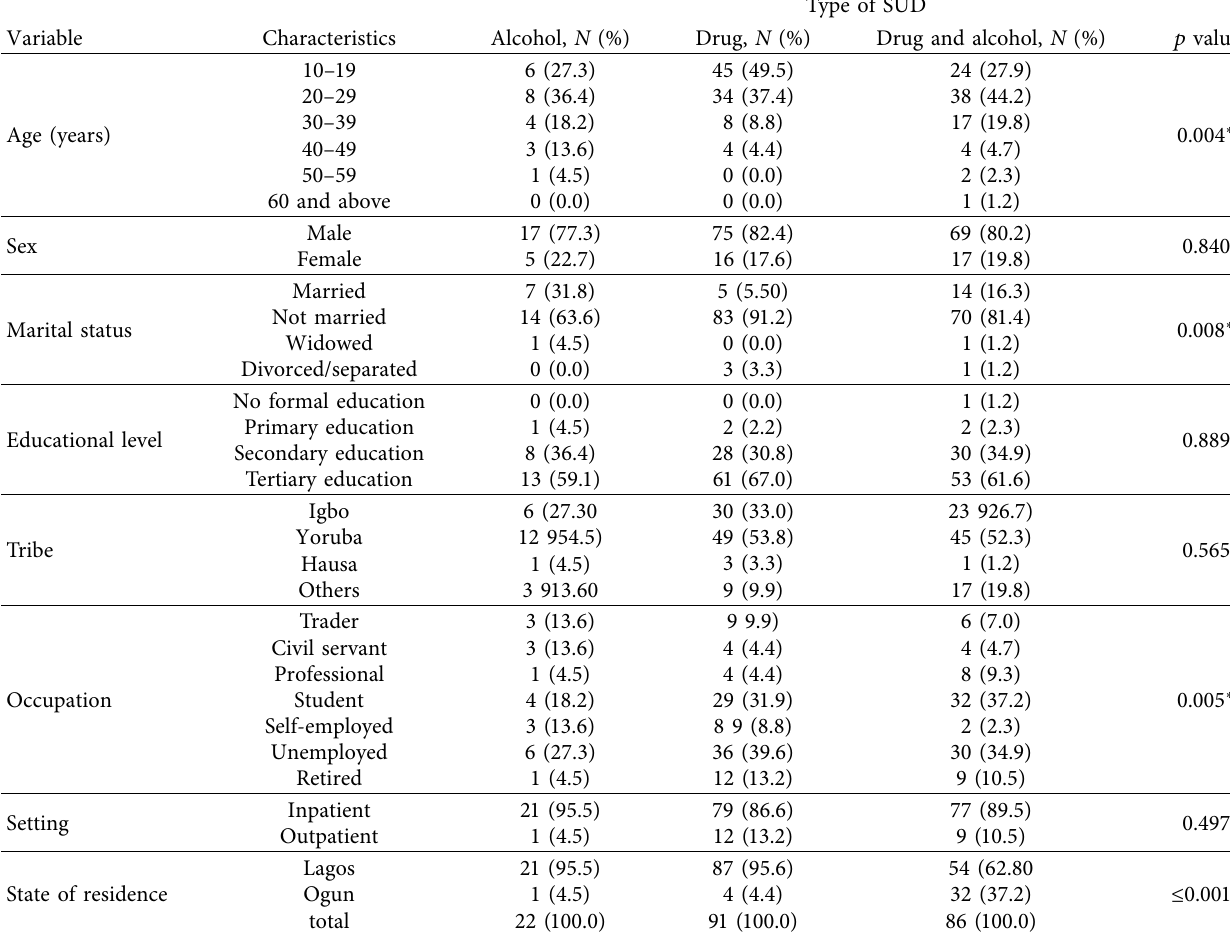
Table 1: Socio-demographic characteristics of the patients.